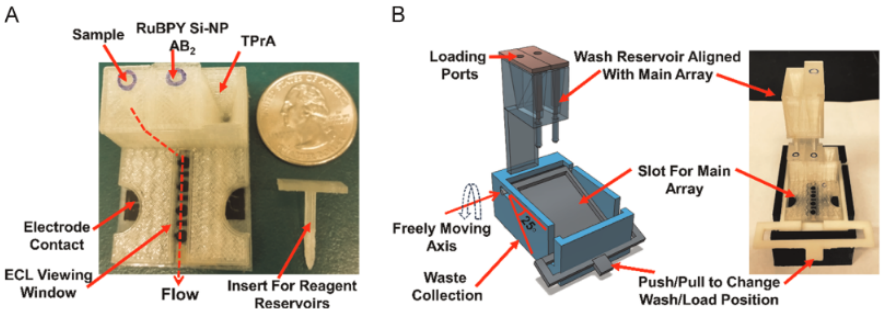
Figure 23. Vlachova et al. microfluidic system: ( A ) microfluidic system scheme composed of hydrolysis and detection parts; ( B ) microfluidic system and detailed picture of the chip with the electrodes. (Reproduced with permission from [35].)